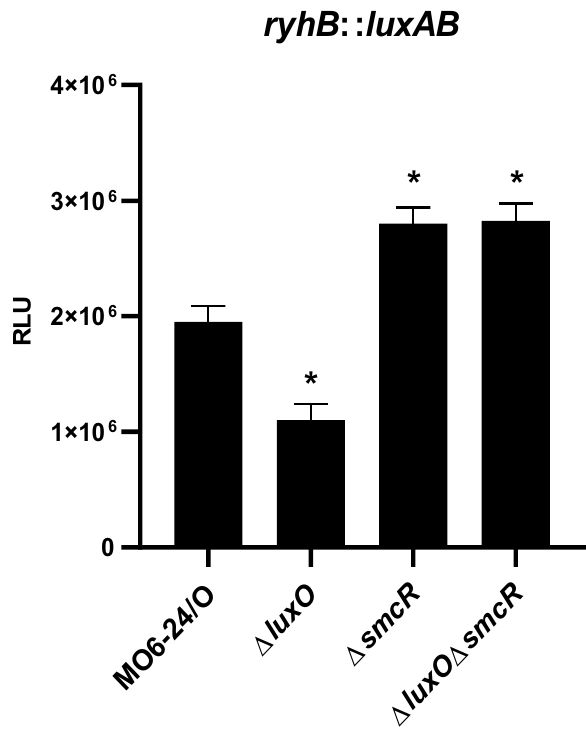
Figure 3. The quorum sensing master regulator SmcR represses the expression of ryhB . Quantitative analysis of ryhB transcription levels using luxAB as reporter genes. Luminescence activity representing the level of ryhB transcription was compared at early stationary phase of growth (A 600 ≅ 1.0) for V. vulnificus MO6-24/O, Δ luxO, Δ smcR, and Δ luxO Δ smcR harboring pHK- ryhB . Relative light units (RLU) were normalized to cell density (luminescence/A 600 ). Values are averages from three independent experiments, and error bars denote standard deviations. The p -values for comparison with MO6-24/O are indicated (Student’s t -test; *, 0.005 ≤ P <